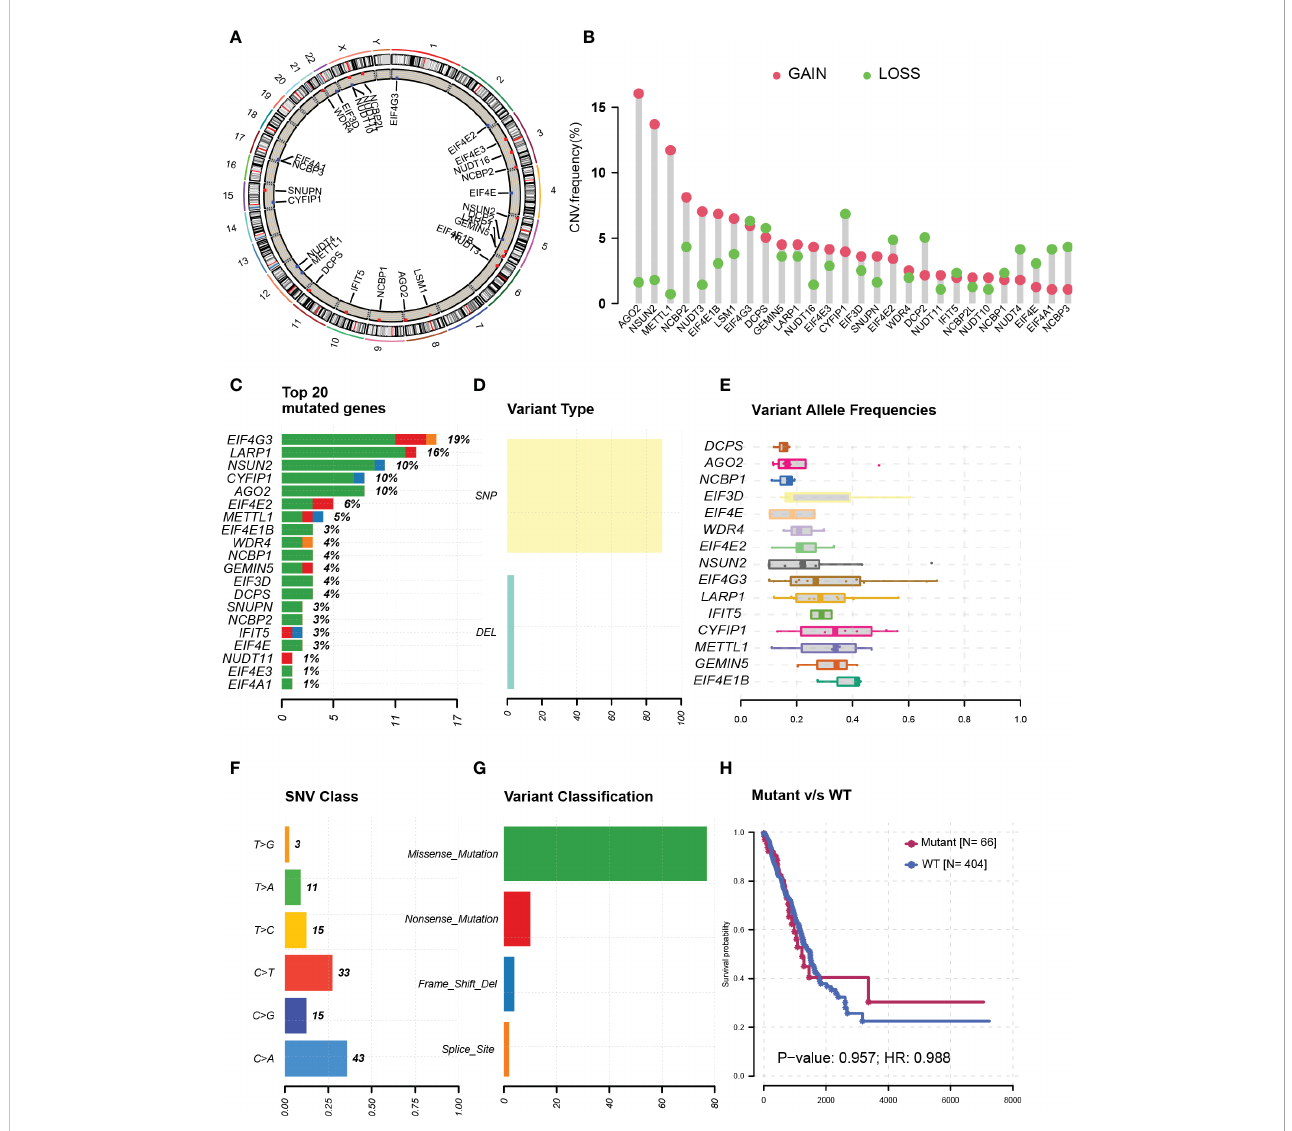
FIGURE 1 Genetic alterations in N7-methylguanosine (m7G) modi fi cation-related genes. (A) m7G modi fi cation-related genes ’ chromosome locations. (B) m7G- related gene copy number ampli fi cation. (C) Top-rating mutated m7G-related genes. (D) Single-nucleotide polymorphisms in all variant types. (E) Variant allele frequencies of m7G-related genes. (F) Single-nucleotide variants of m7G-related genes. (G) Variant classi fi cation of m7G-related genes. (H) Survival analysis between mutant and wild-type patients. CNV: Copy number variation; SNP: Single-nucleotide polymorphism; DEL: Gene deletion; WT: Wild type; SNV: Single nucleotide variant; HR: Hazard